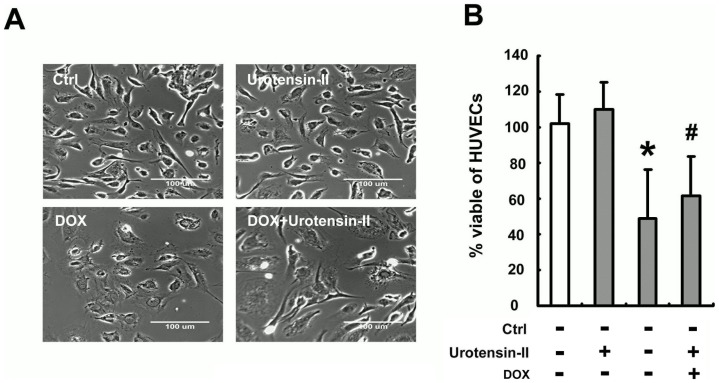
U-II protected HUVECs from DOX -induced apoptosis.(A) Photomicrographs from phase-contrast microscopy. Cell death induced by 24 h exposure to DOX (1 µM) in HUVECs replaced with fresh cell culture medium or treatment or pretreatment with U-II medium. (B) Percent cell viability using MTT assay. Densitometric data are means ± SEM from three separated experiments. *P <0.05 vs. control (Ctrl); #
P <0.05 vs. DOX treatment.